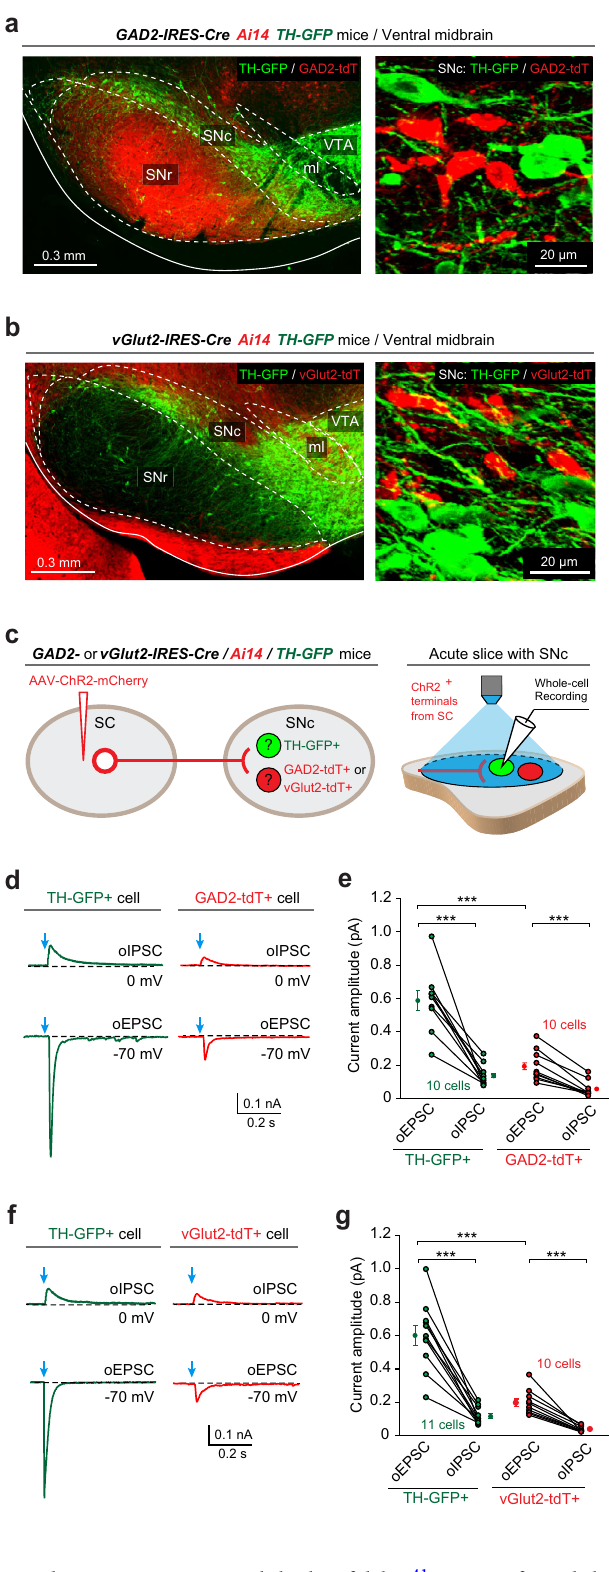
SNc dopamine neurons with higher fi delity 41 . We con fi rmed this observation (Supplementary Fig. 3a, b) and used TH-GFP mice to genetically label SNc dopamine neurons. By crossing Ai14 (ref. 42 ) with GAD2-IRES-Cre mice 43 , we labeled putative SNc GAD2 + neurons with tdTomato (GAD2-tdT; Supplementary Fig. 3c, d). Similarly, Ai14 was crossed with vGlut2-IRES-Cre NATURE COMMUNICATIONS| (2021) 12:4409